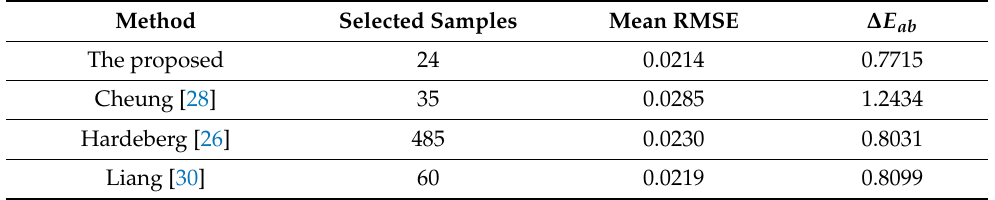
Figure 9. The relationship between mean color difference and distance ( a ) Columnar statistical chart and ( b ) Linear statistical graph. Table 3. Compares recovery error for Optimal Selected Training Samples in difference methods.